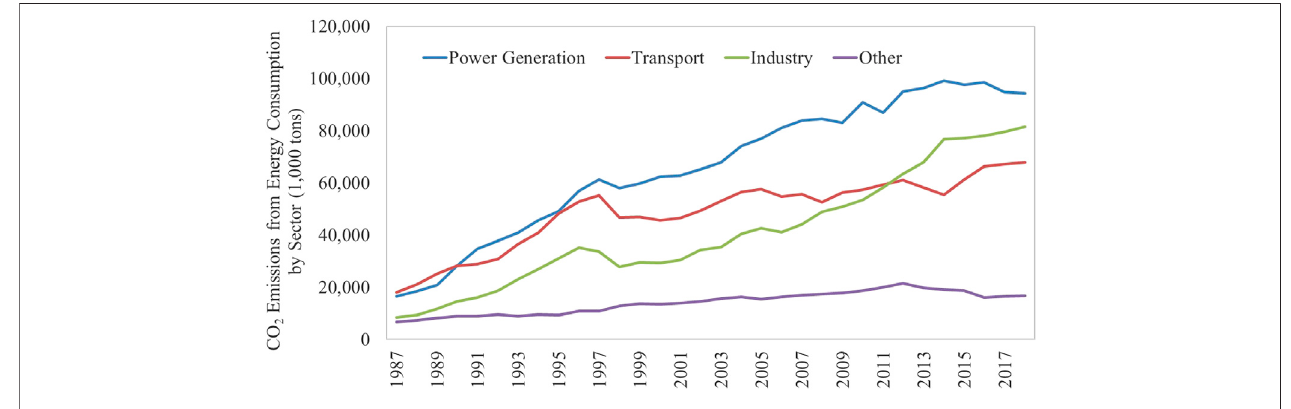
FIGURE 6 | CO 2 emissions from energy consumption by sector (EPPO,